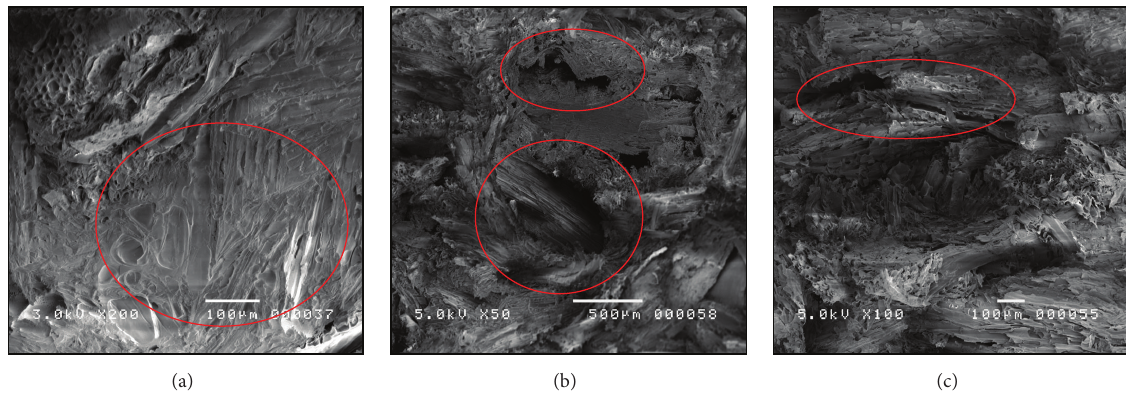
Figure 12: UF sago particleboard. (a) Particle bond with the UF matrix (b). (c) Boundary of the particles/void/debonding.